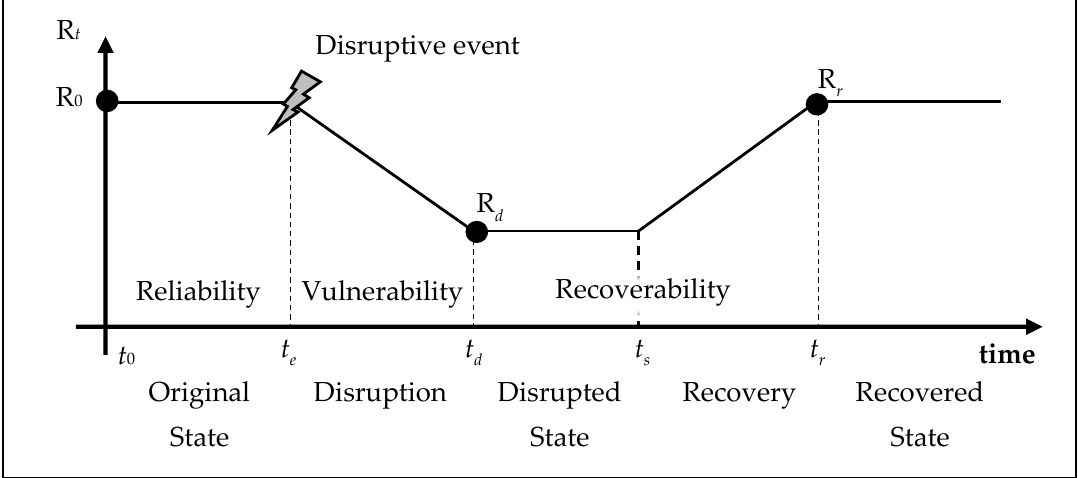
Figure 3. Different states in a resilient network over time [11]. Figure 3. Di ff erent states in a resilient network over time